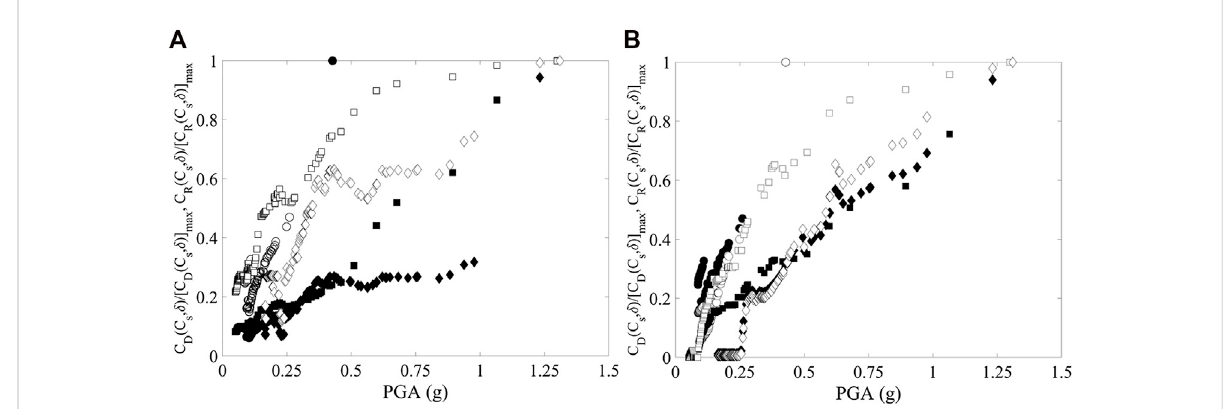
FIGURE 9 Variation of C D ( C s | δ ) / [ C D ( C s | δ )] max (solid symbols) and C R ( C s | δ ) / [ C R ( C s | δ )] max (hollow symbols) with respect to PGA: (A) RC buildings without NLVDs; (B) RC buildings with NLVDs. Location of the RC buildings: Mexico City (circles), Puebla (squares), Guerrero